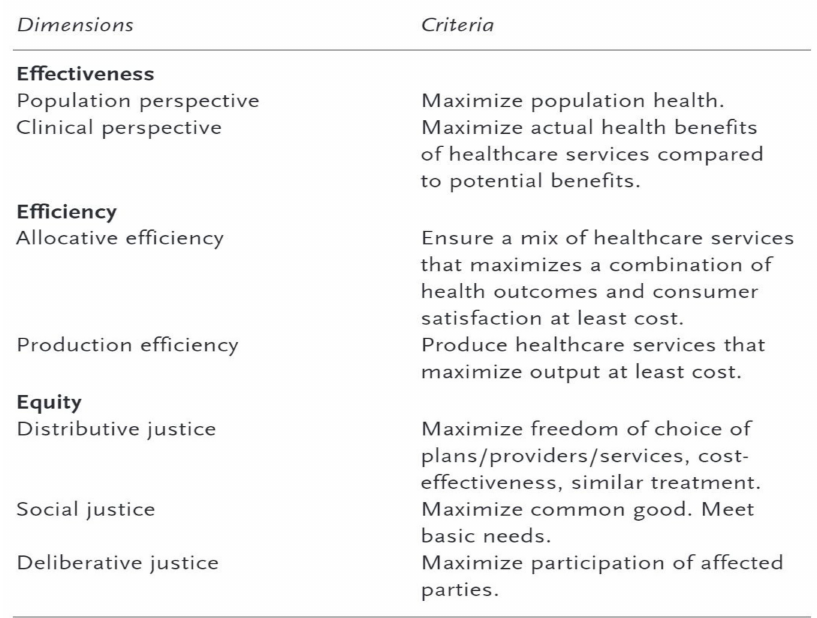
Figure 3. Dimensions and criteria to evaluate health policy utilizing health services’ research model